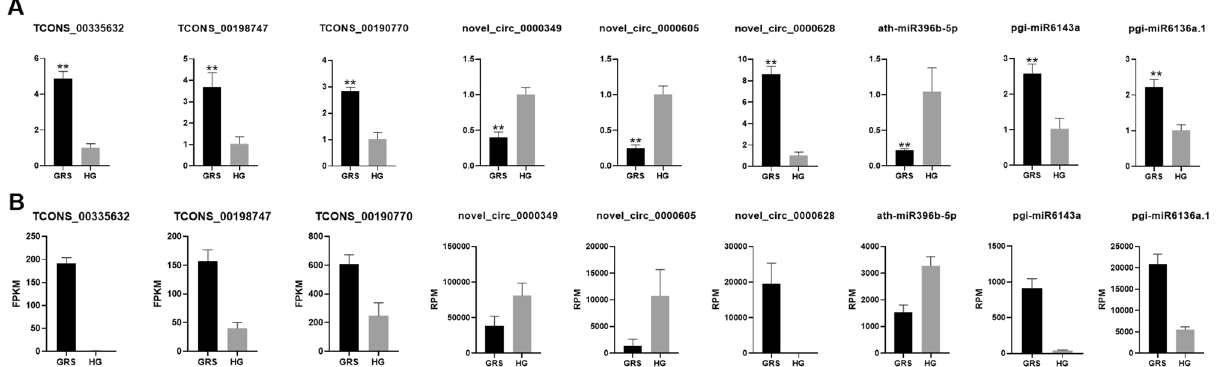
Figure 10. qRT-PCR validation of significant differentially expressed genes. ( A ) qRT-PCR, the data were presented as the mean ± SEM (n = 3); **p < 0.05; ( B ) RNA-seq. The figure was created by using GraphPad Prism 7 (https:// www. graph pad.